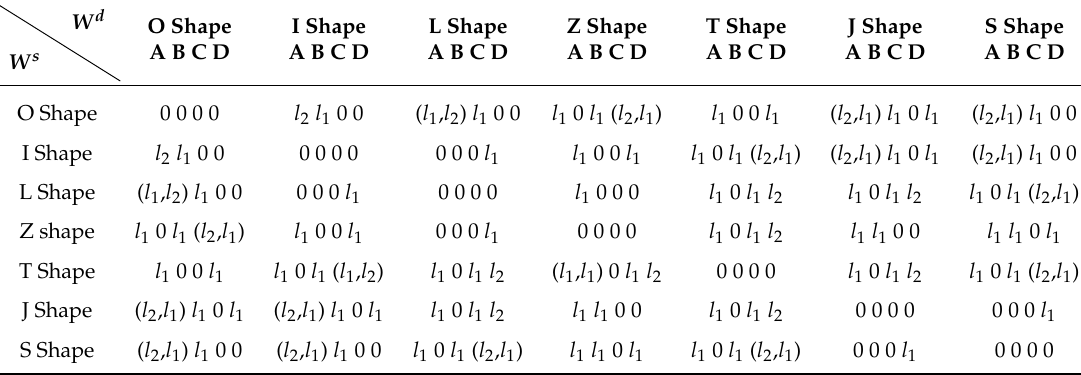
= ϕ s ∗ − ϕ s when hTtro transforms its shape from Source waypoint W s h h h